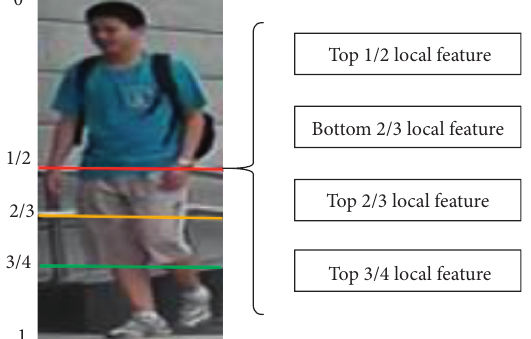
Figure 6: Schematic diagram of multiproportion block and